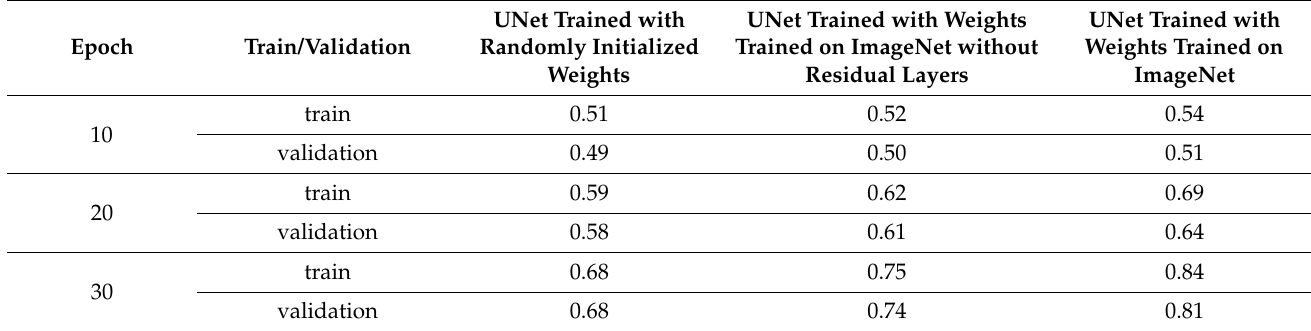
Table 3. Comparison of the UNet training results on IoU metric throughout epochs.